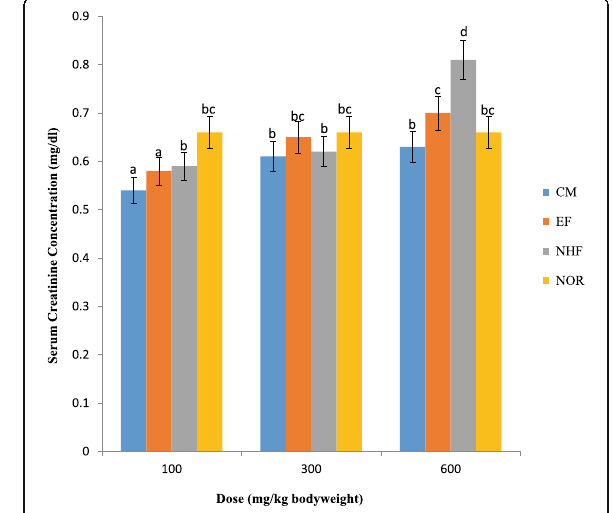
Fig. 8 Effect of crude extract and fractions of Gymnema sylvestre on serum creatinine concentrations of rats. Mean with different superscripts differ significantly (p < 0.05). Key: NOR: normal control, CM: crude methanol extract, EF: ethyl acetate fraction, NHF: n-hexane